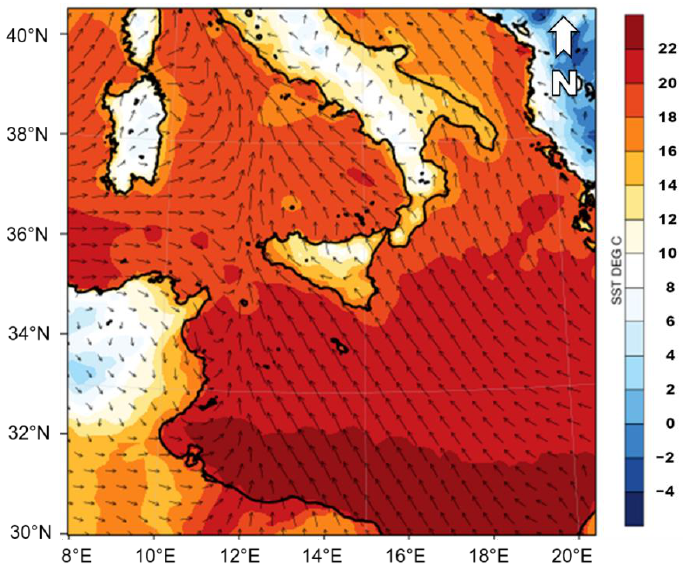
Figure 3. Analysis of SST and surface wind currents. The figure shows the high temperatures of the sea surface that favors the increase of the moisture of the air masses that fly over